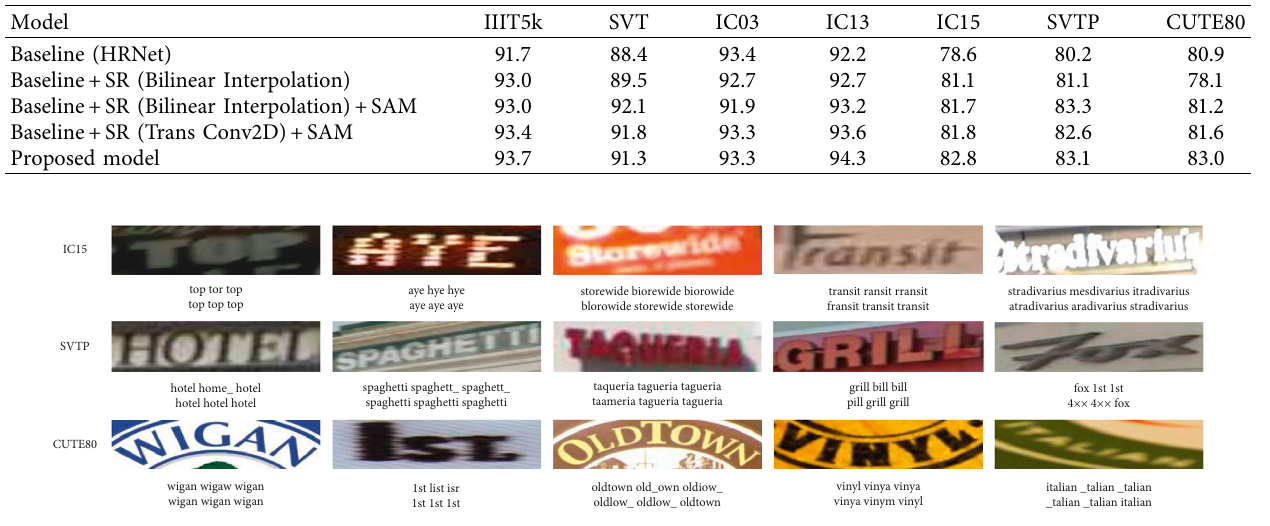
Table 2: Comparison of accuracy of ablation models (%).